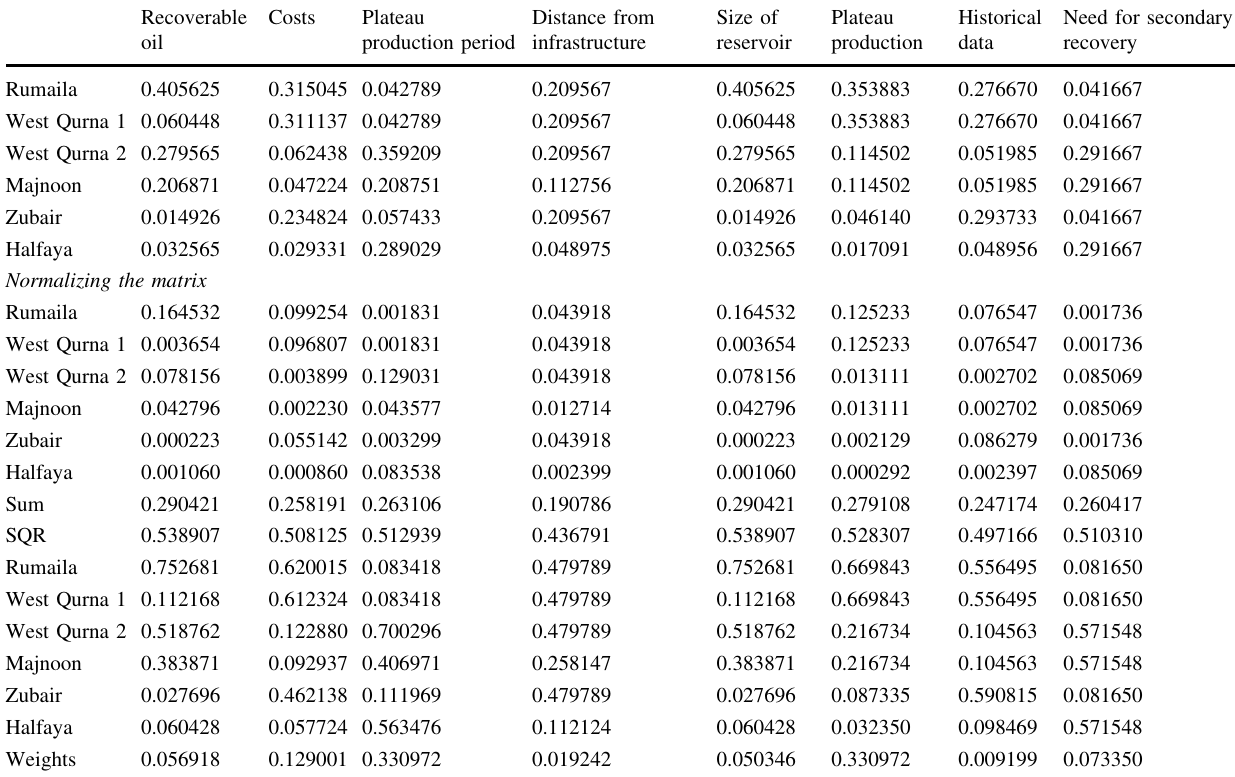
Table 11 TOPSIS—priority